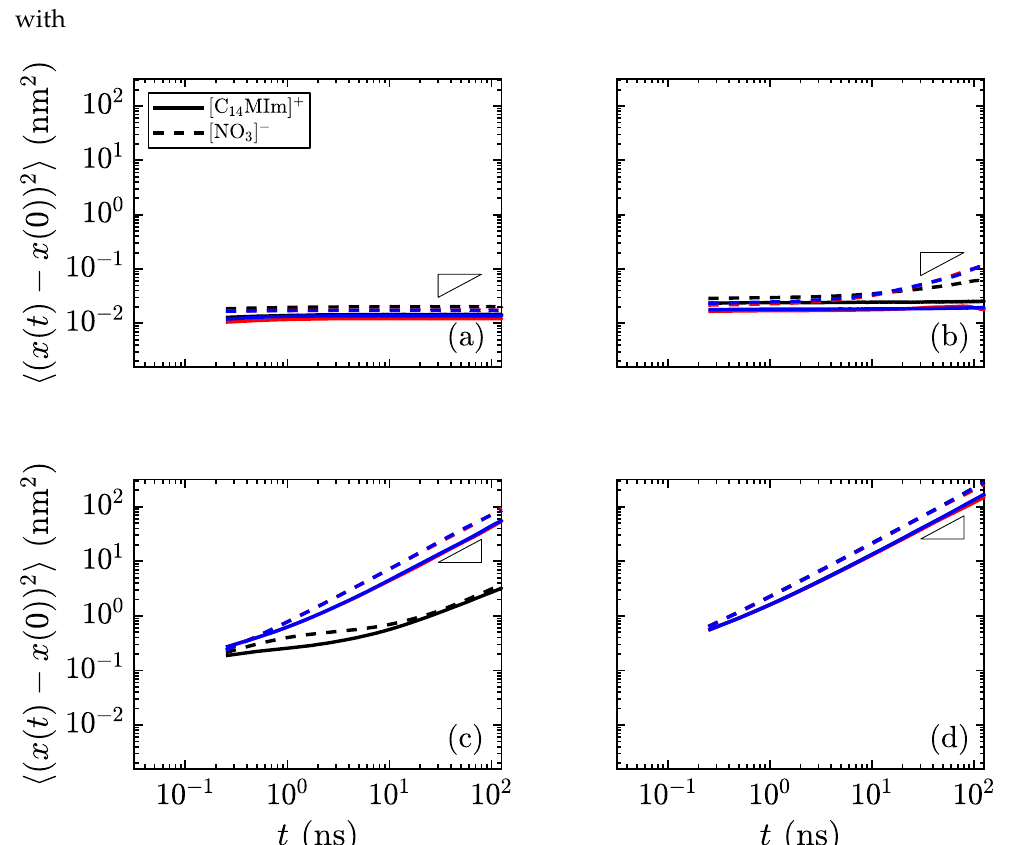
Figure 7. Mean-squared displacement of the species in [C 14 MIm][NO 3 ] as a function of time at temperatures of ( a ) 400K in the crystalline state, ( b ) 450K just before the transition to smectic, ( c ) 500K in the smectic-A phase, and ( d ) 600K isotropic liquid. Reference slopes of 1, indicated as small triangles, help to identify the linear diffusive regime. The colors signify the dimension (red: x , blue: y , black: z ); the solid lines are for the long cations and the dotted lines are for the nitrate anions. The most distinctive difference is the divergence of the z -direction from the x - and y -directions in the smectic-A phase, showing that transport within a layer is much simpler than through the layers. (Notes: ( c ) The x - and y -directions are nearly overlapping. ( d ) All directions nearly collapse, indicating an isotropic